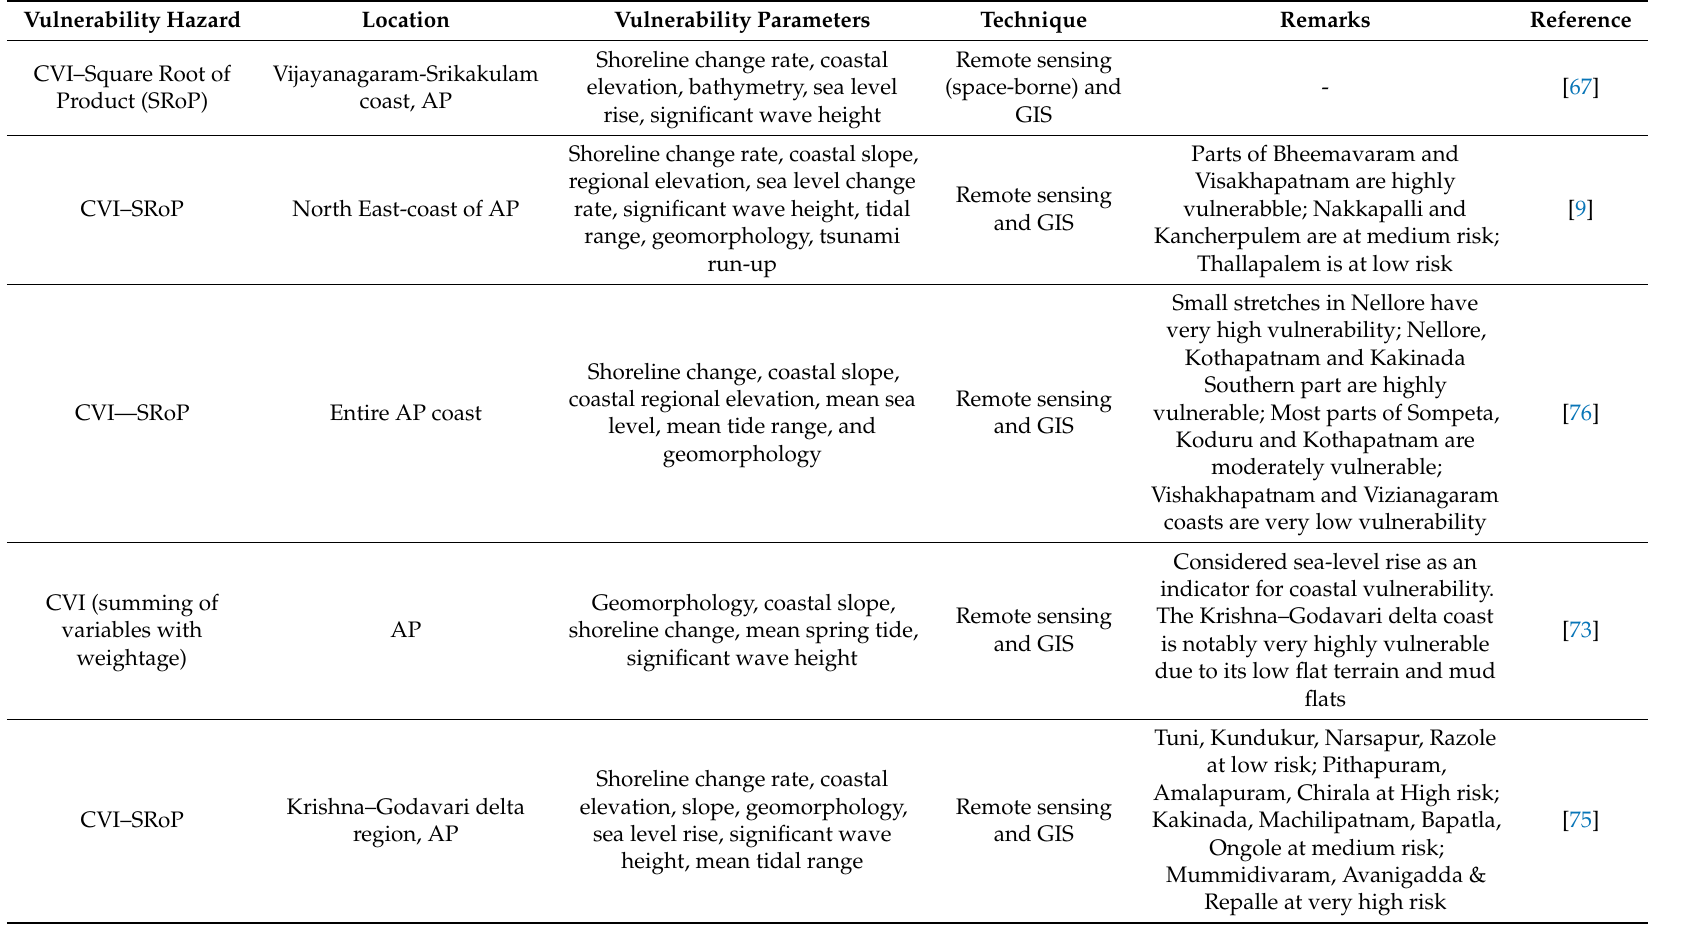
Table 5. Vulnerability assessment and parameters considered for different geographic locations of Andhra